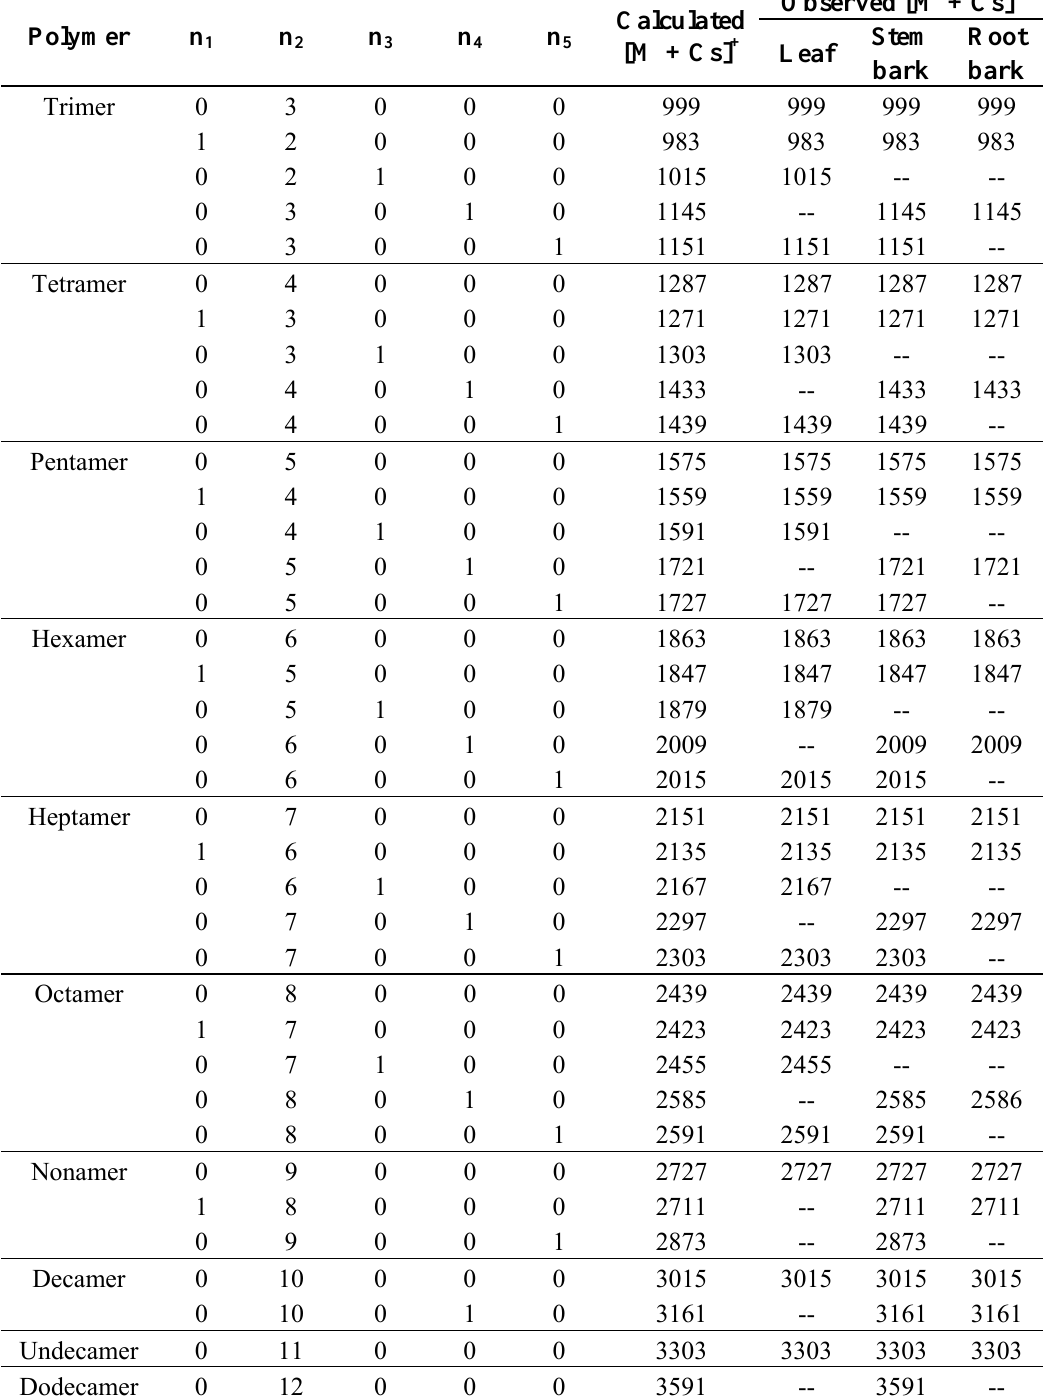
Table 2. MALDI-TOF MS of condensed tannins from different parts of A. confusa .